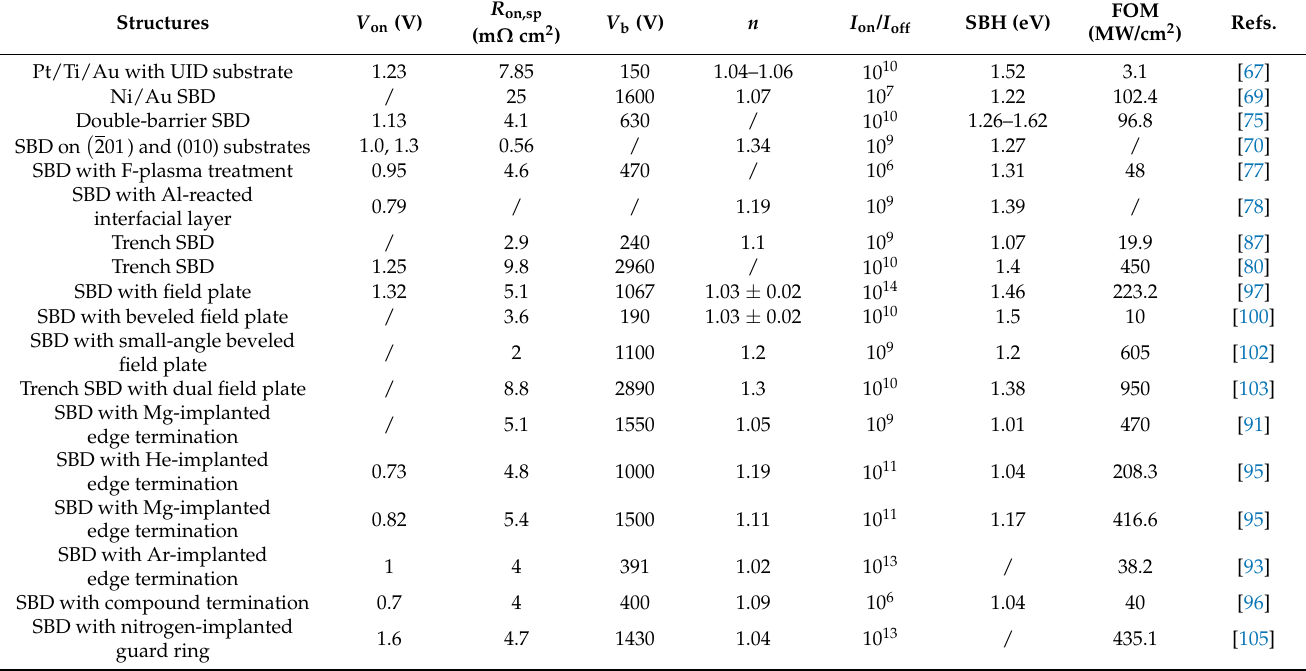
Table 2. Comparison of electric performances for β -Ga 2 O 3